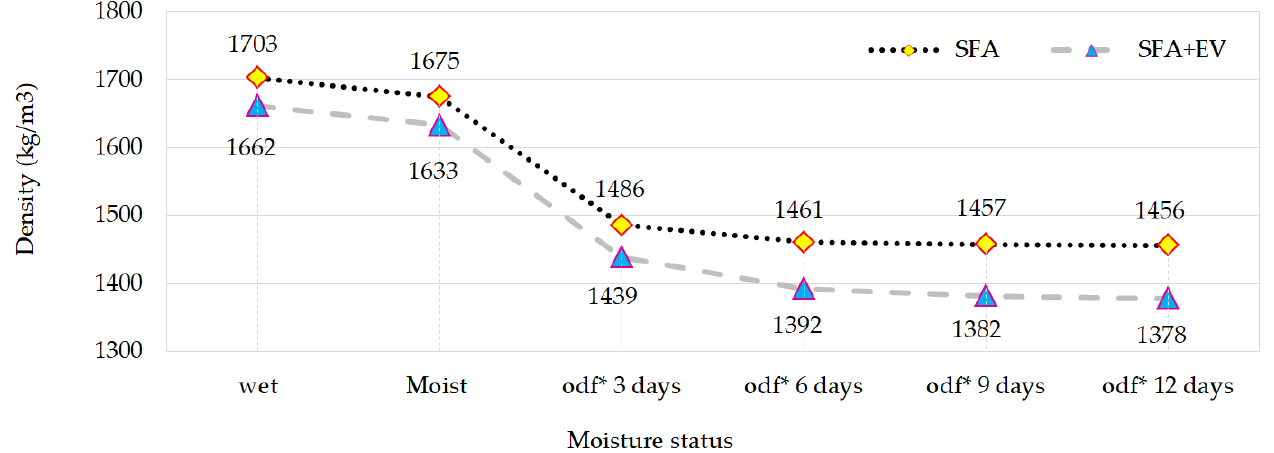
Figure 5. Density of SFA and SFA + EV concretes in different saturation states (odf — oven dry for).